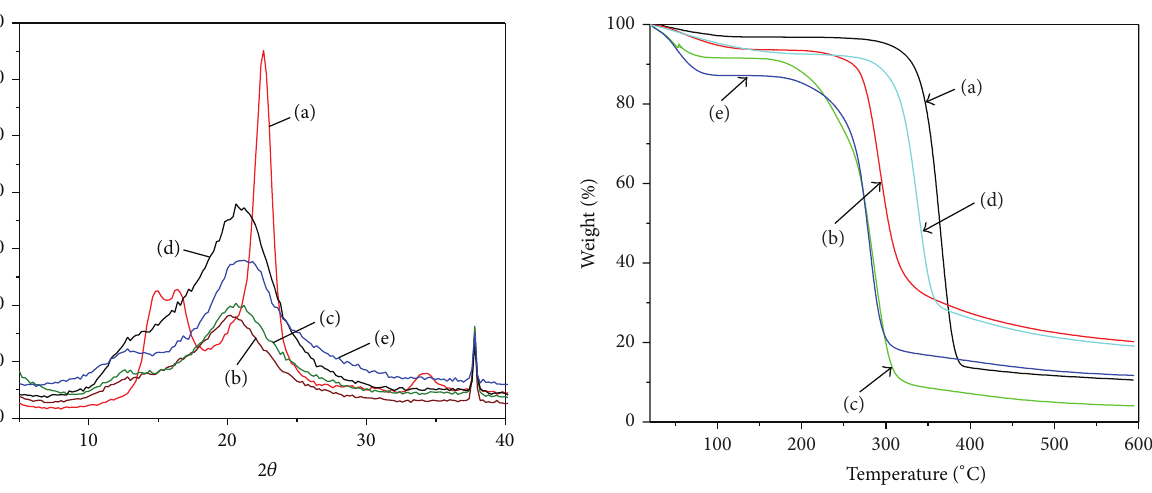
Figure 5: TGA of films, (a) virgin fibers, (b) AmimCl, (c) BmimCl, (d) EmimCl, and (e)